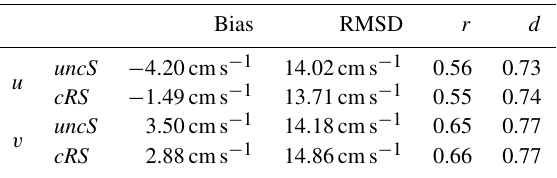
Table 3. Statistics comparing the modeled water currents at P3 with data from the HF